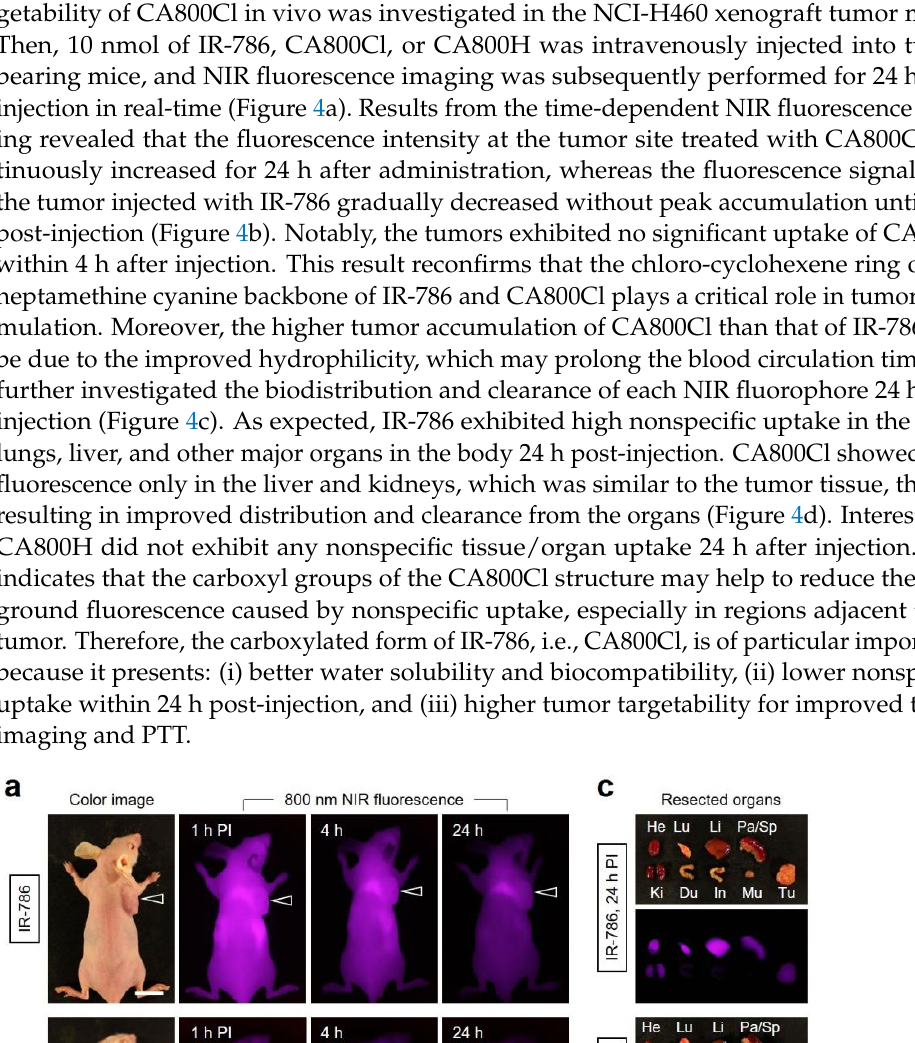
Figure 4. In vivo NCI-H460 tumor targeting efficiency and biodistribution of NIR fluorophores. ( a ) NIR fluorescence imaging at 1 h, 4 h, and 24 h post-injection of IR-786, CA800Cl, and CA800H, respectively. ( b ) Time-dependent fluorescence intensities at the tumor sites targeted by each NIR fluorophore. ( c ) Resected organs and tumors imaged 24 h after injection of each NIR fluorophore. ( d ) Quantitative fluorescence analysis of intraoperative dissected organs 24 h post-injection of each NIR fluorophore. The tumor site is indicated by an arrowhead. Abbreviations: Du, duodenum; He, heart; In, intestine; Ki, kidneys; Li, liver; Lu, lungs; Mu, muscle; Pa, pancreas; Sp, spleen; Tu, tumor; and PI, post-injection. Scale bars = 1 cm. All NIR fluorescence images have identical exposures and normalizations. Data are expressed as mean ± S.D. (n = 3). ** p < 0.01. 3.4. In Vitro and In Vivo Photothermal Effects To examine the photothermal effect of CA800Cl, we monitored temperature variations in solutions of CA800Cl (100 μM in PBS) and PBS alone irradiated by an 808 nm NIR laser (1.1 W/cm 2 ) for 1 min. The temperature changes were monitored in real-time using a thermal imager. The temperature of the CA800Cl solution remarkably increased from 27.5 to 80.4 °C under laser irradiation for 1 min, whereas the PBS alone displayed no temperature change under the same conditions (Figure 5a). The temperature of the CA800Cl solution rapidly reached approximately 70 °C within the first 30 s of laser irradiation and was maintained up to 80 °C for the next 30 s of irradiation (Figure 5b). Based on the equation described in the Materials and Methods section, the photothermal conversion efficiency ( η ) of CA800Cl was calculated to be 30.2%, which is comparable to that of the heptamethine cyanine dyes that were reported previously [21,22]. This suggests that CA800Cl can be used as an effective PTT agent for in vivo photothermal tumor ablation. Additionally, three cycles of laser irradiation were repeatedly performed using the CA800Cl solution to evaluate its photothermal stability (Figure 5c). As expected, the temperature of the CA800Cl solutions rapidly decreased in the second cycle and was